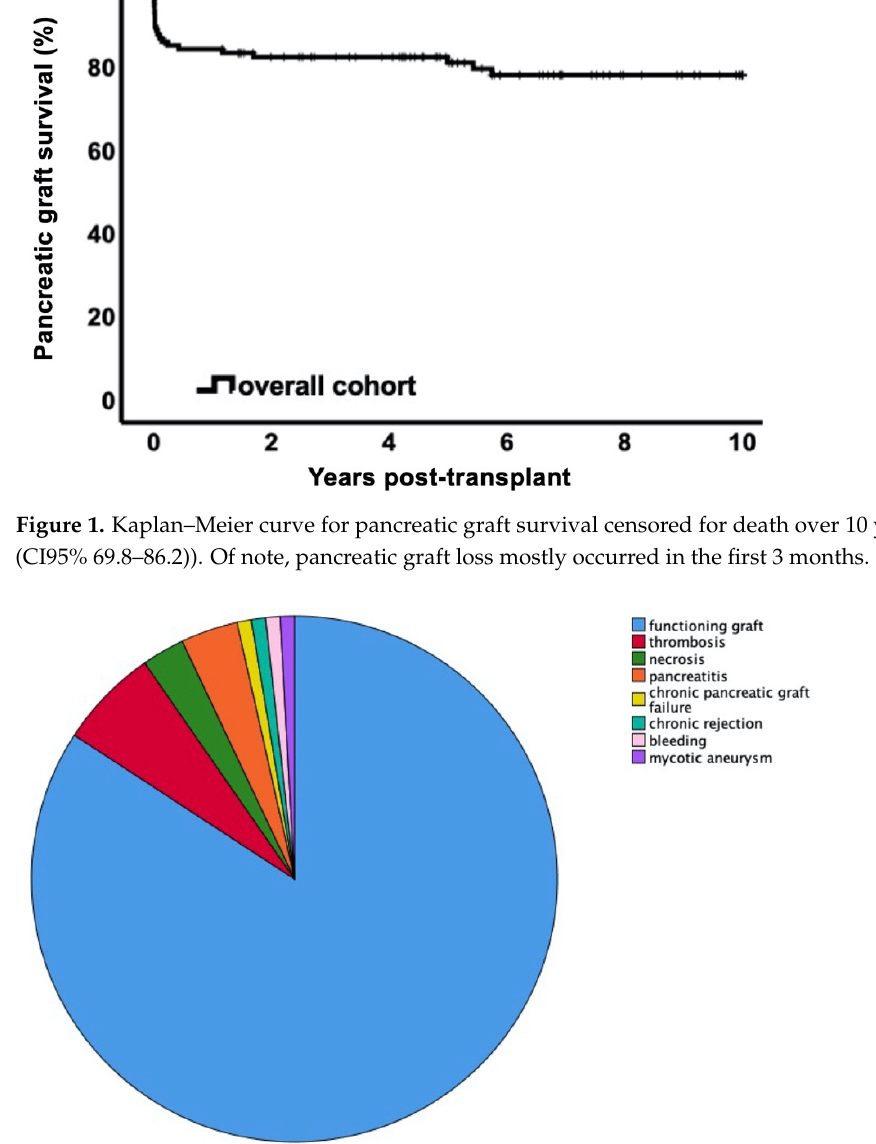
Figure 2. Causes of early pancreas graft loss within 3 months.